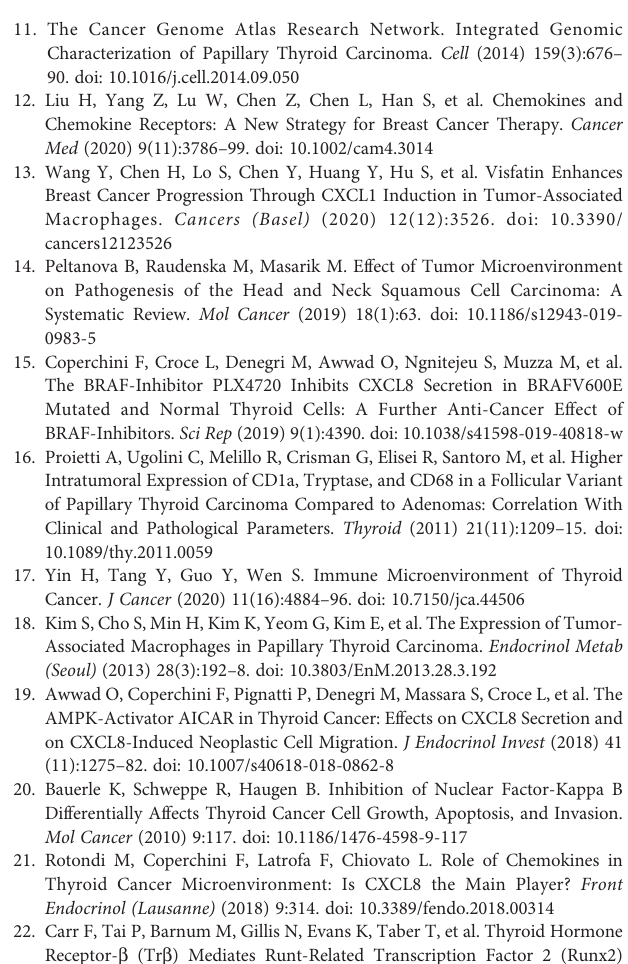
Supplementary Figure 2 | Kaplan – Meier survival curves based on 12 DEGs. Progression-free survival analysis revealed that higher expression levels of 5